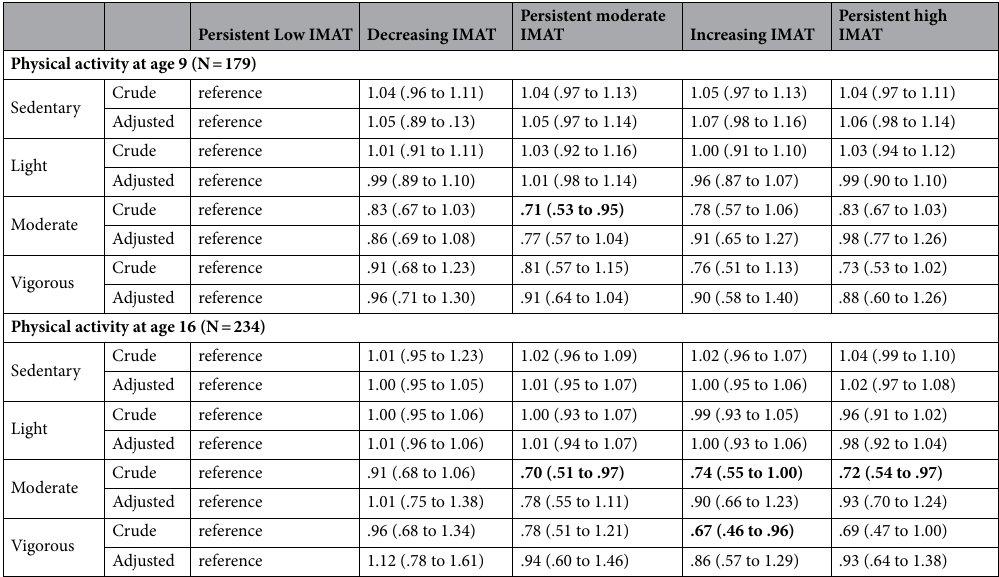
Table 5. Adjusted and unadjusted associations between physical activity at ages 9 and 16 and muscle morphology changes between ages 13 and 16. a All values are relative risk ratios (95% confidence interval) per 10 min of physical activity. All estimates adjusted for accelerometer wear time. Adjusted values additionally control for sex and body mass index at age 21. Intramuscular adipose tissue is abbreviated as IMAT. Significant values are in